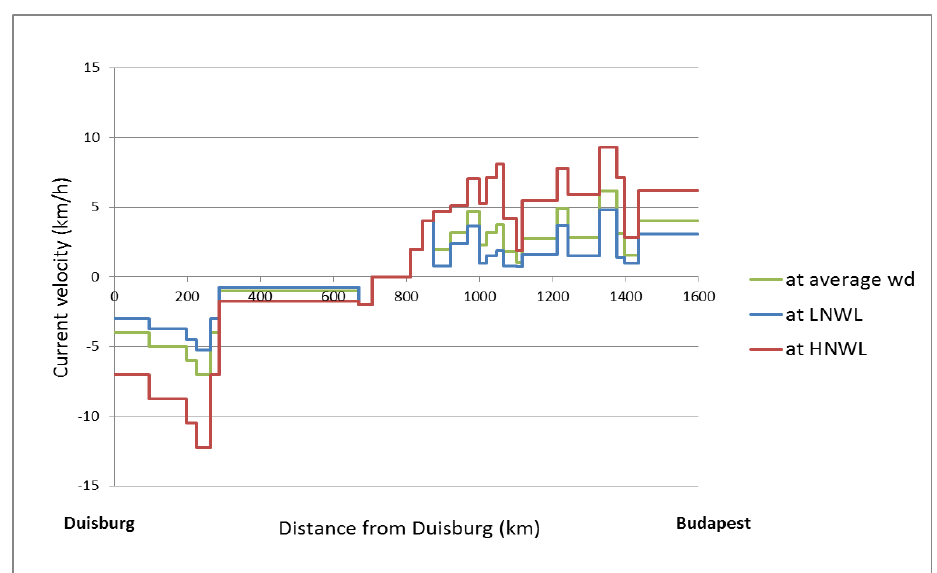
Figure 5. Current velocity distribution along the route, sailing from Duisburg to